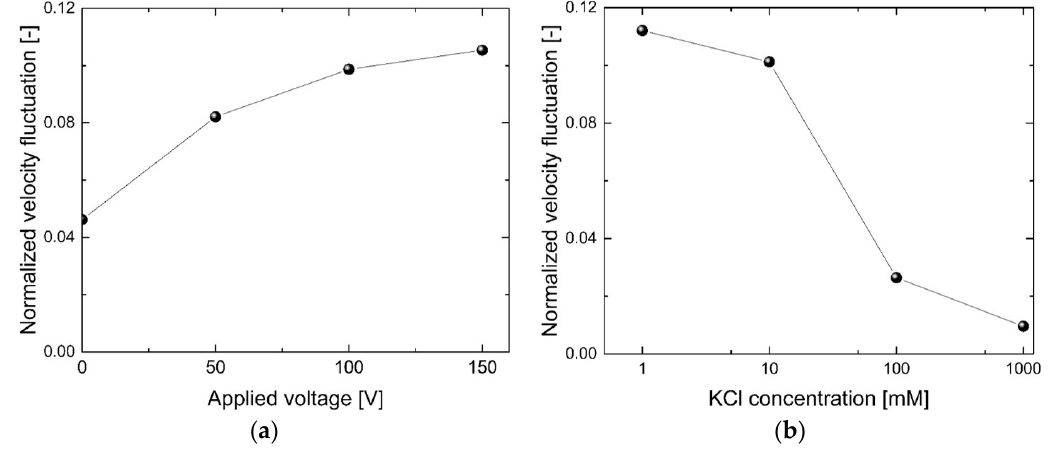
Figure 6. Normalized velocity fluctuation versus ( a ) applied voltage and ( b ) KCl concentration.